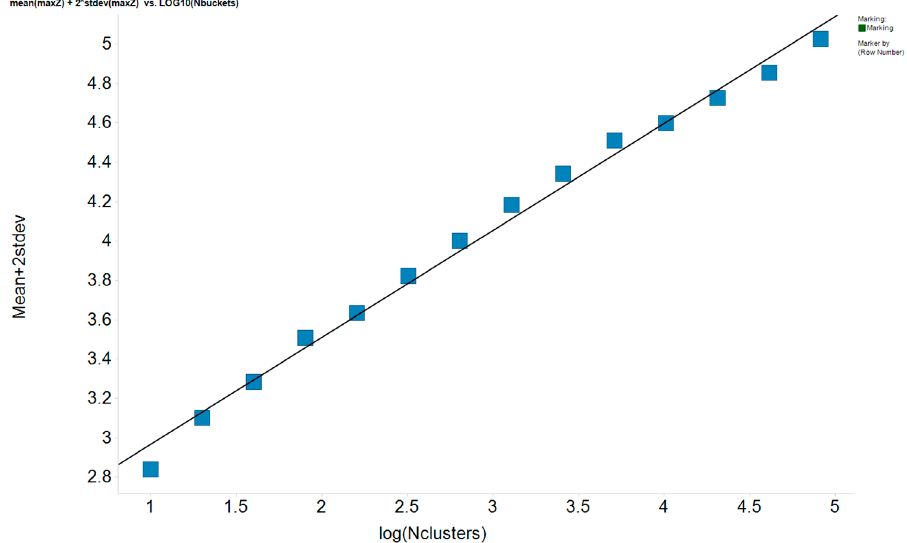
Figure 10. Relationship between the statistically significant level of maxZ and the number of clusters.